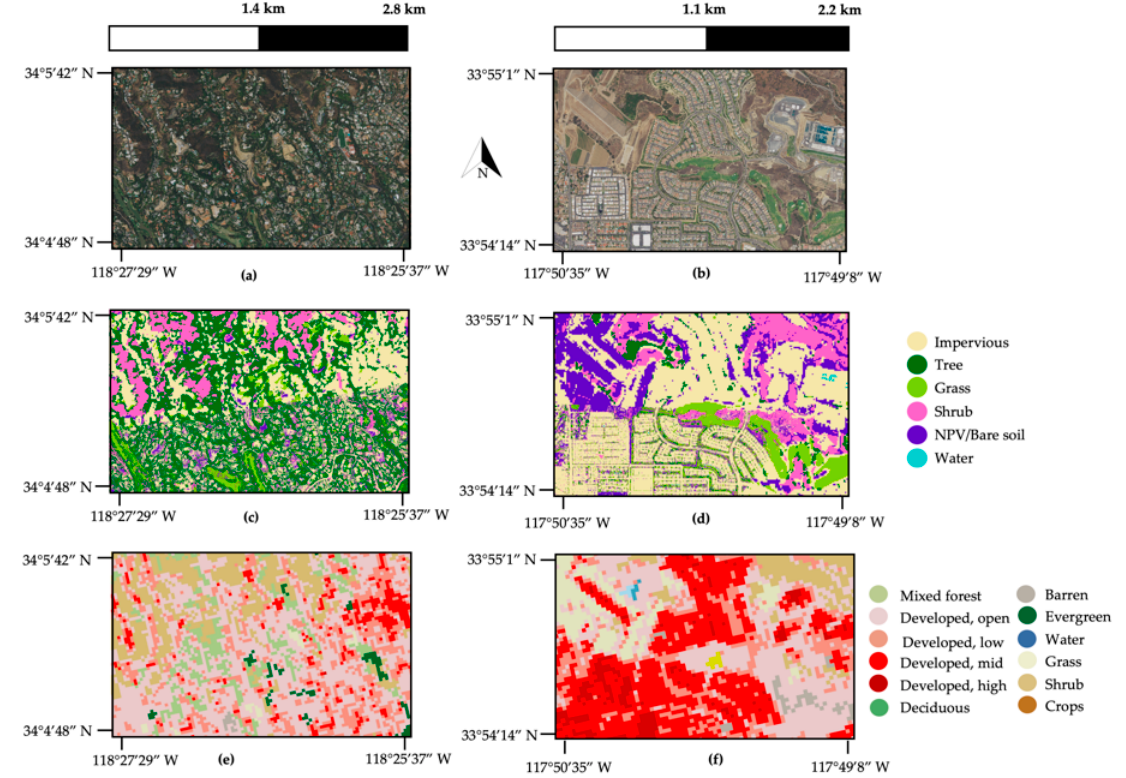
Figure 7. Our final NAIP and Sentinel-2 combined classification for SoCAB provided a significant improvement in spatial resolution over the previous NLCD classification at a high accuracy of 85%, successfully differentiating between six distinct land cover classes and minimizing the shadow effects on land cover classification at 0.6 to 10 m resolution. This classification was highly effective in urban and non-urban regions of SoCAB, using 10 m Sentinel-2 imagery and 0.6 m NAIP imagery: ( a ) West Hollywood, Los Angeles, California; ( b ) Carbon Canyon Regional Park in Brea, California. ( c , d ) 10 m Sentinel-2 imagery is used classify non-urban regions and 0.6 m NAIP imagery is used to classify urban areas to increase overall accuracy. ( e , f ) Significant urban and suburban vegetation is visible in our classification, in comparison to mixed “low-intensity” to “medium-intensity” and shrub classification in the original NLCD classification. Table 3. Confusion matrix for NAIP/Sentinel-2 classification with overall accuracy of 85% and weighted overall accuracy of 88%.